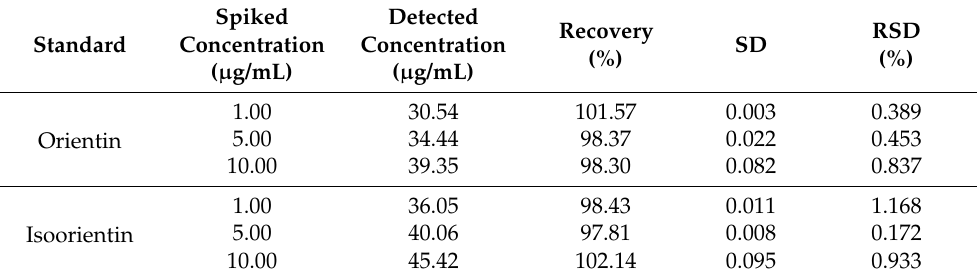
Table 3. Recovery study of orientin and isoorientin in VB extract ( n = 3).